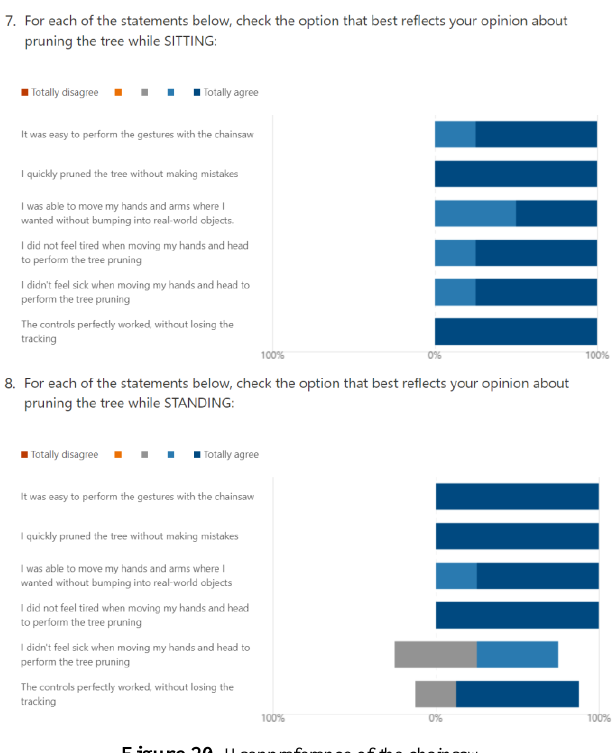
Figure 20. User preference of the chainsaw.